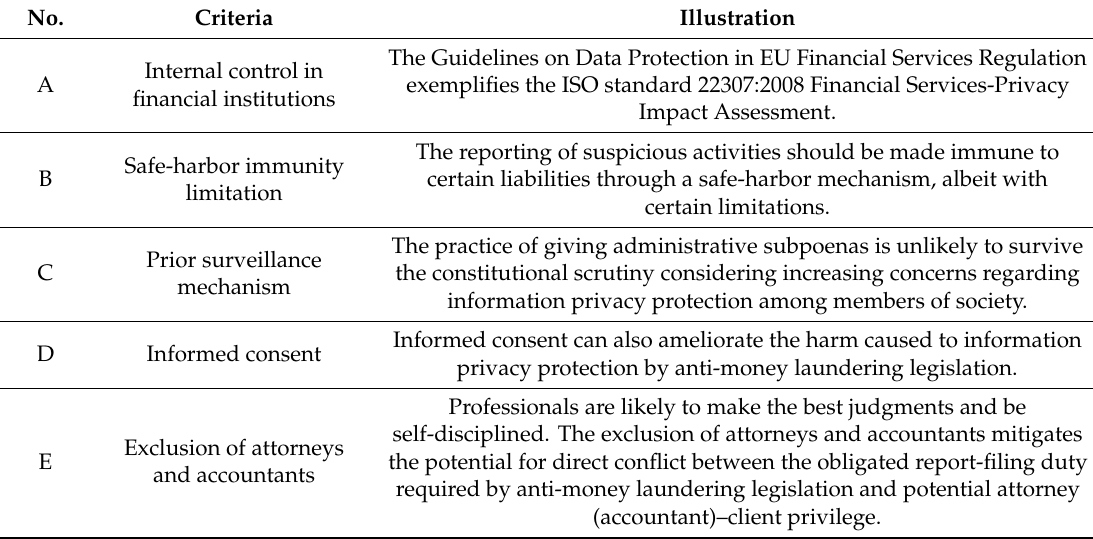
Table 1. Criteria to be considered in the analytic hierarchy